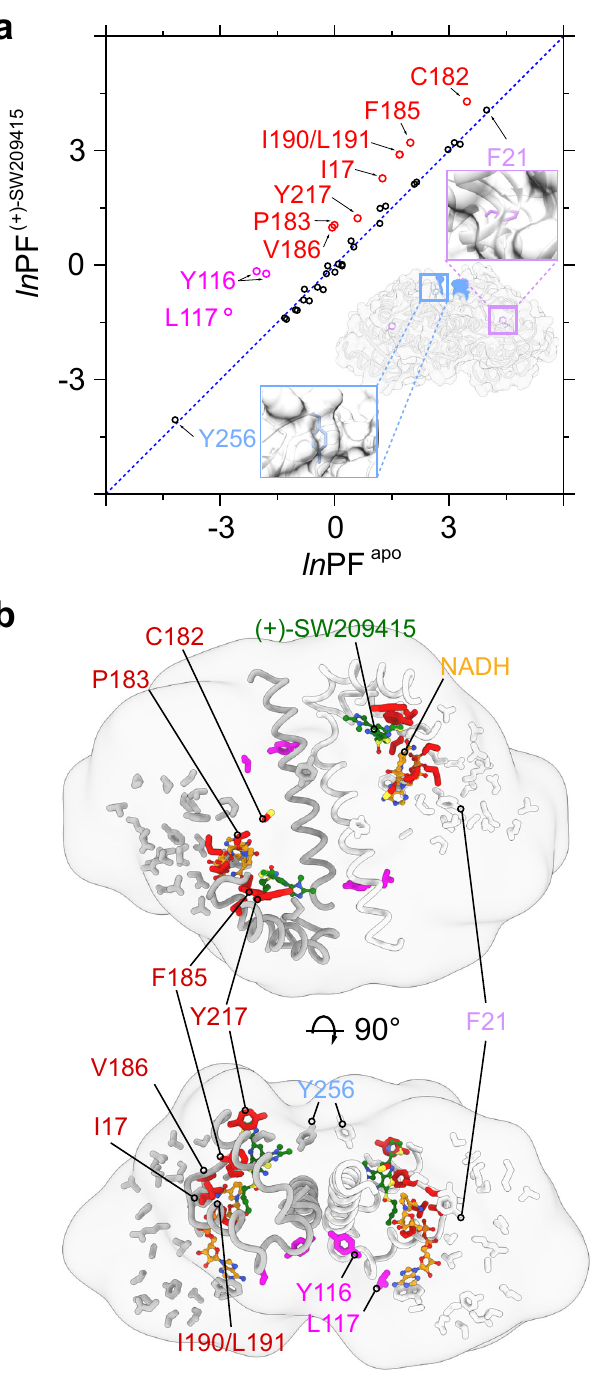
Fig. 3 | Hydroxyl radical footprinting of human 15-PGDH in the absence and presenceof(+)-SW209415.a ScatterplotforProtectionFactor(PF)analysisofthe hydroxyl radical footprinting data with ( y axis) and without ( x axis) (+)-SW209415 bound.TherelativePFvalueofaresidueindicatesitslocationwithintheprotein,as illustrated by two examples. F21 is buried deep insidethe protein, whileY256 is on the surface of the protein. Residues on the upper left triangle become more pro- tectedin the presence of (+)-SW209415.Residues involvedin either NADH or drug bindingarecoloredinred,residuesinvolvedinthedimericinterfacearecoloredin magenta. b Mappingoftheprobesidenti fi edinhydroxylradicalfootprintingonthe (+)-SW209415-bound human 15-PGDH structure. These residue probes are shown as stick with the same color code used in panel a. NADH and (+)-SW209415 are depicted in orange and green ball-and-stick models. Residues that are more pro- tected with (+)-SW209415 are clustered around the drug-binding pocket and, speci fi cally, the nicotinamide moiety of NADH. Two additional residues, Y116 and L117, localizeto the 15-PGDH homodimeric interface and are moreprotected when (+)-SW209415 is